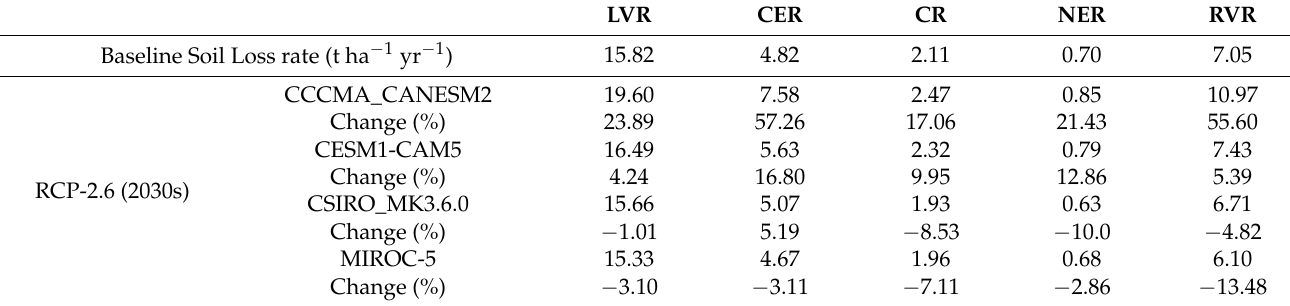
Figure 14. ( Top ) Predicted average rainfall erosivity in Kenya under all scenarios for the 2030s and 2080s time periods; ( Bottom ) predicted average soil erosion rates in Kenya under all scenarios for the 2030s and 2080s time periods. Table 16. Projected change to the mean baseline soil loss rate (%) across the regions of